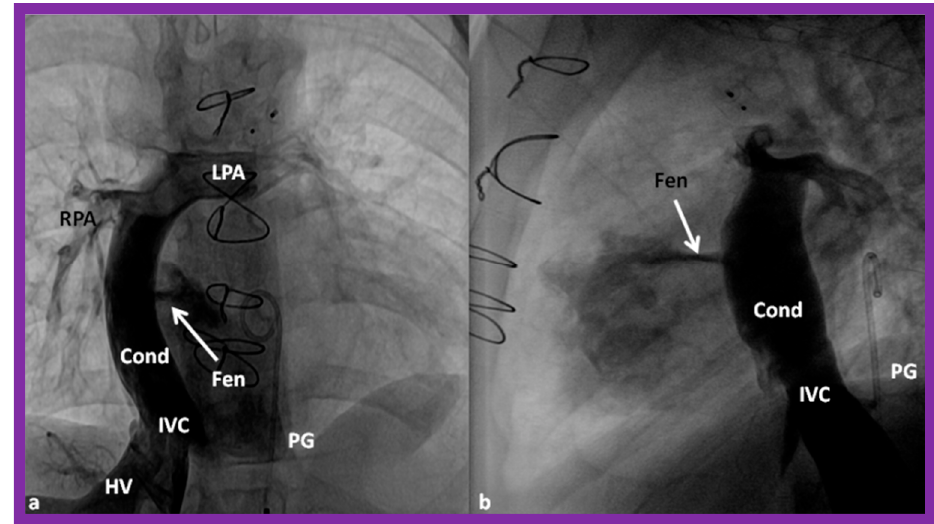
Figure 8. Selected cine frames in the posteroanterior ( a ) and lateral ( b ) projections, demonstrating Stage IIIA of the Fontan procedure redirecting the inferior vena caval (IVC) blood flow into the left (LPA) and right (RPA) pulmonary arteries via a non-valved conduit (Cond). The flow of the angiographic material across the fenestration (Fen) is pointed out with arrows in both ( a , b ). The hepatic veins (HV) and pigtail catheter (PG) in the descending aorta are labeled. Modified from [63].